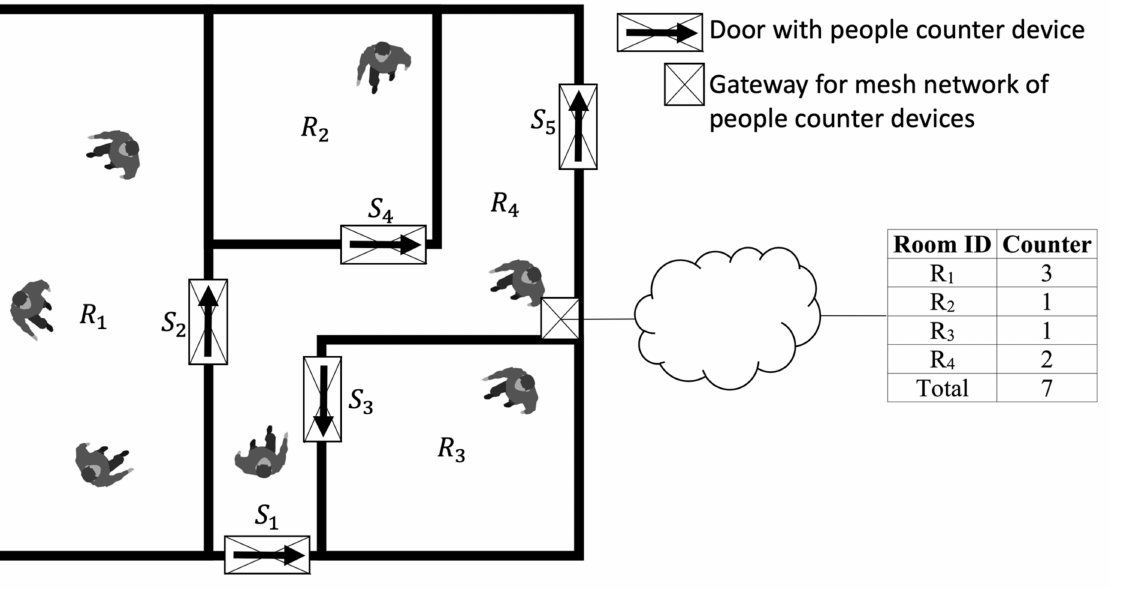
Figure 3. Case study: monitoring people presence in